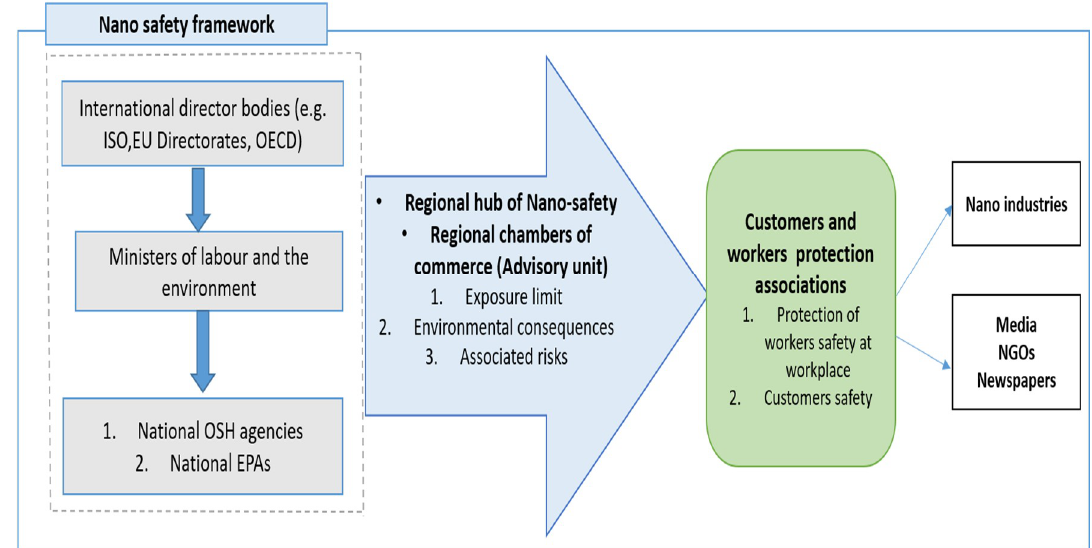
Figure 16. Nano-safety framework for enhanced safety in the nano-industry. Adopted from [180].